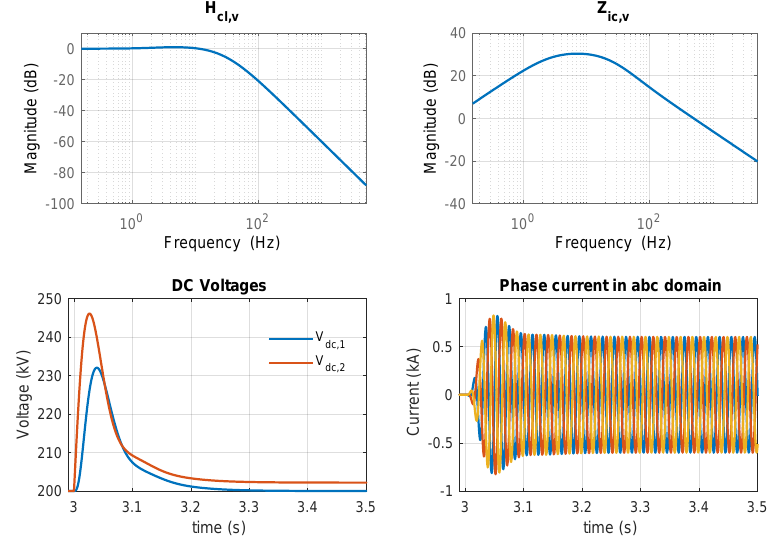
Figure 8. ( Top left ) Frequency response of closed-loop output to reference transfer function; ( Top right ) frequency response of input impedance from DC (base case); ( Bottom left ) time response of DC voltages; ( Bottom right ) time response plot of phase currents in abc domain.